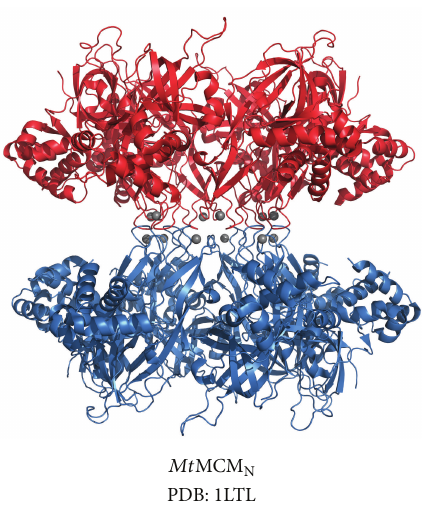
Figure 5: 𝑀𝑡 MCM double-hexamer crystal structure. The N 𝑀𝑡 MCM double-hexamer crystal structure is shown in cartoon N representation with onehexamer colored redand theotherblue. The two hexamers interact head to head via subdomain B interactions. Zinc atoms are shown as gray spheres. The figure was prepared with the Pymol software package [88] and PDB accession code